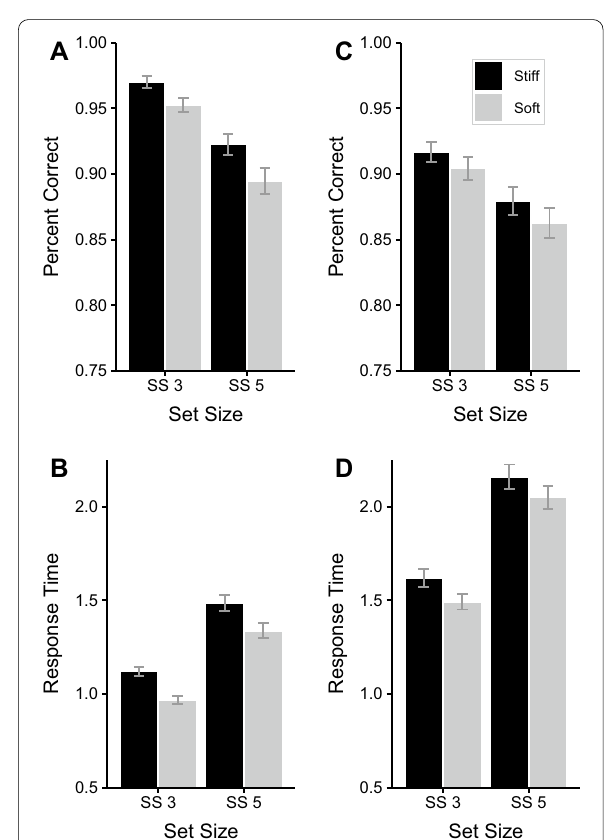
Fig. 2 Mean accuracy and response time for Experiments 1 ( A , B ) and Experiment 2 ( C , D ). SS set size. Error bars are standard error